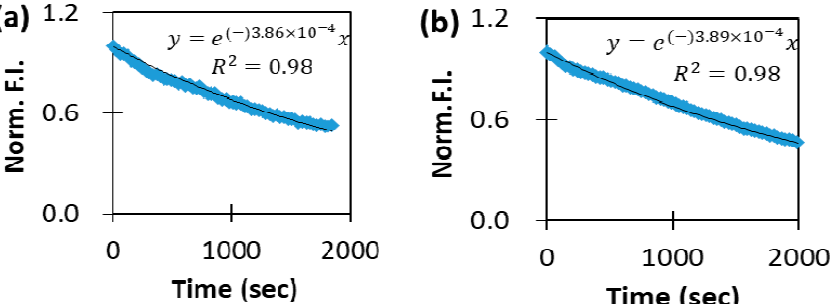
Figure 2. Comparison of oxidation resistance of AcTDA and TDA. Normalized fluorescence intensity after 4 mM H 2 O 2 was added to 20 µ M of ( a ) AcTDA and ( b ) TDA with 200 mg/dL glucose in 1 × PBS (pH 7.4).